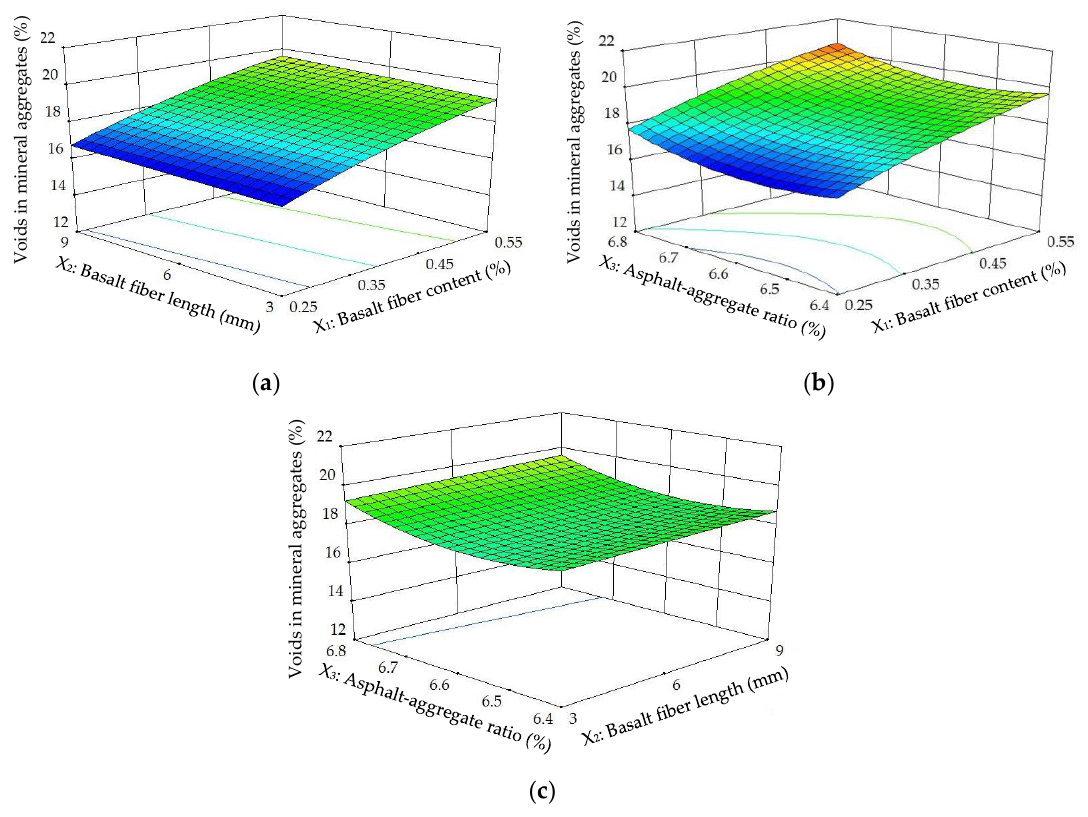
Figure 13. Response surface plots between VMA and factors: (a) Factors: BFC and BFL at AAR = 6.6%; ( b ) Factors: BFC and AAR at BFL = 6 mm; ( c ) Factors: BFL and AAR at BFC = 0.4%.